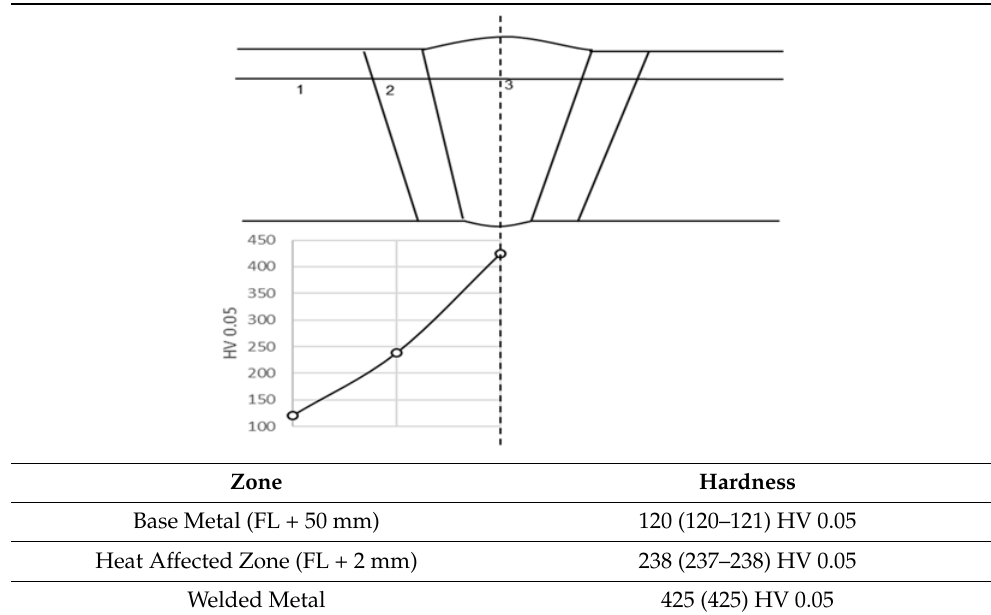
Figure 6 . Fusion line micrography; ( a ) left side; ( b ) right side.